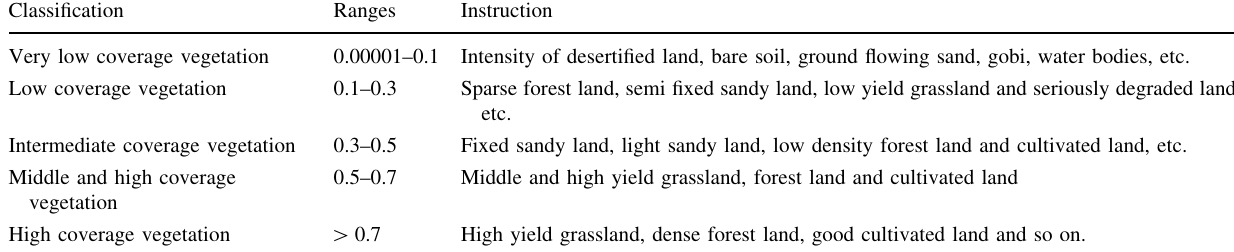
Table 1 Classification scheme used in this